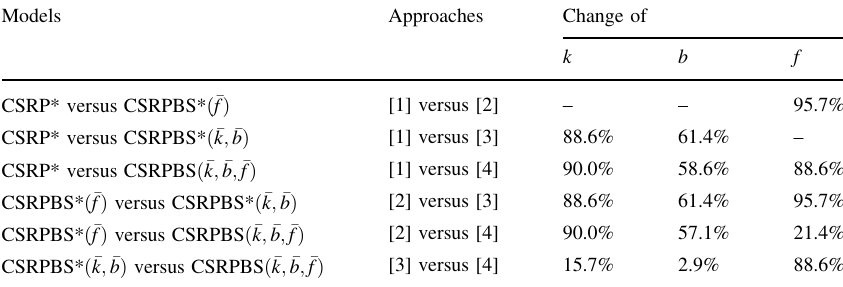
Table 3 Changes in solution structure Models